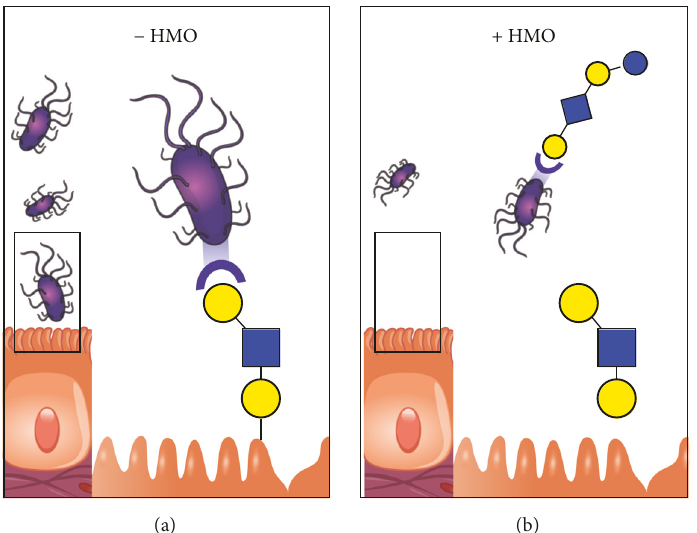
Figure 4: Adhesion of pathogens to gut wall in (a) absence of HMOs and (b) presence of HMOs. The adhesion of the pathogens to the gut wall is prevented by HMOs that serve as decoy.